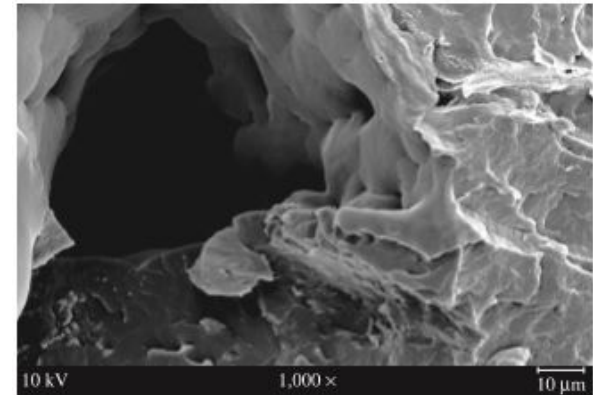
Figure 17: SEM micrographs of the tensile fracture surfaces of the RHF–PP composites with different filler loadings. (a) 10 wt.% filler loading, (b) 20 wt.% filler loading, (c) 30 wt.% filler loading, (d) 40